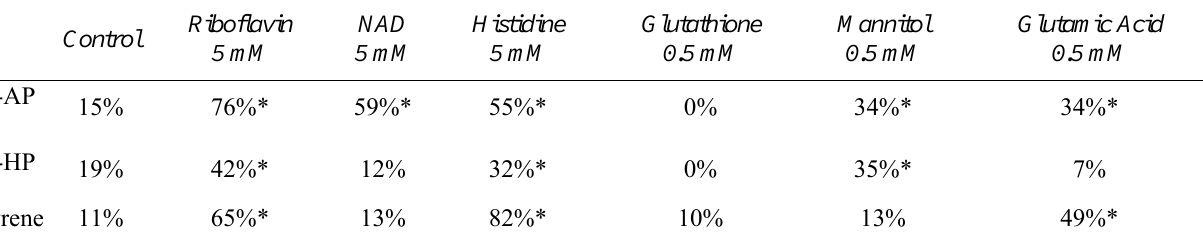
Table 2: Percent of DNA photocleavage by 1-AP, 1-HP, and pyrene in the presence of biologically relevant molecules Riboflavin NAD